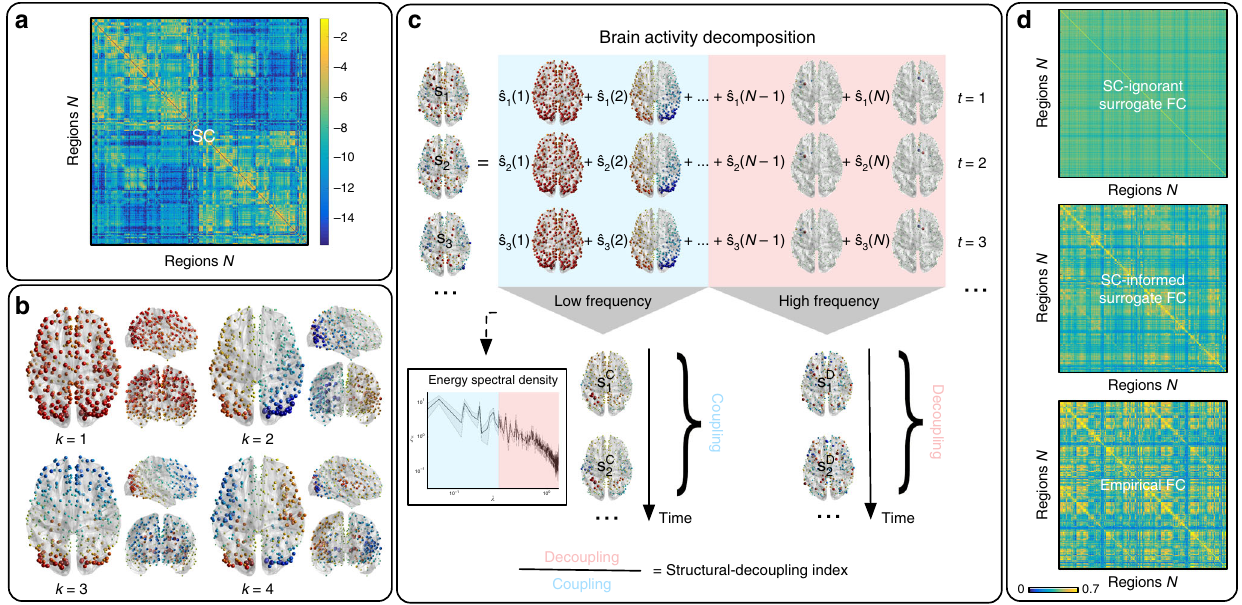
Fig. 1 Method pipeline. a Structural connectome (SC) between N ¼ 360 atlas regions, displayed in logarithmic scale. b SC eigendecomposition leads to structural harmonics with increasing spatial frequency k . c Brain activity at every time point t ( s t ) is written as a linear combination of harmonics (by using coef fi cients ^ s t ). The median-split criterium on the activity energy spectral density ξ (inset) is used to split the spectrum and decompose brain activity into coupled/decoupled portions s C t and s D t (using low/high-frequency harmonics, respectively; λ = harmonic frequency). The ratio between decoupled/coupled signal norms is de fi ned as structural-decoupling index. d Surrogate functional signals are generated with/without knowledge of SC, by spectral coef fi cient randomization. Average functional connectomes (FC) obtained from correlating pairs of empirical/surrogate functional signals are